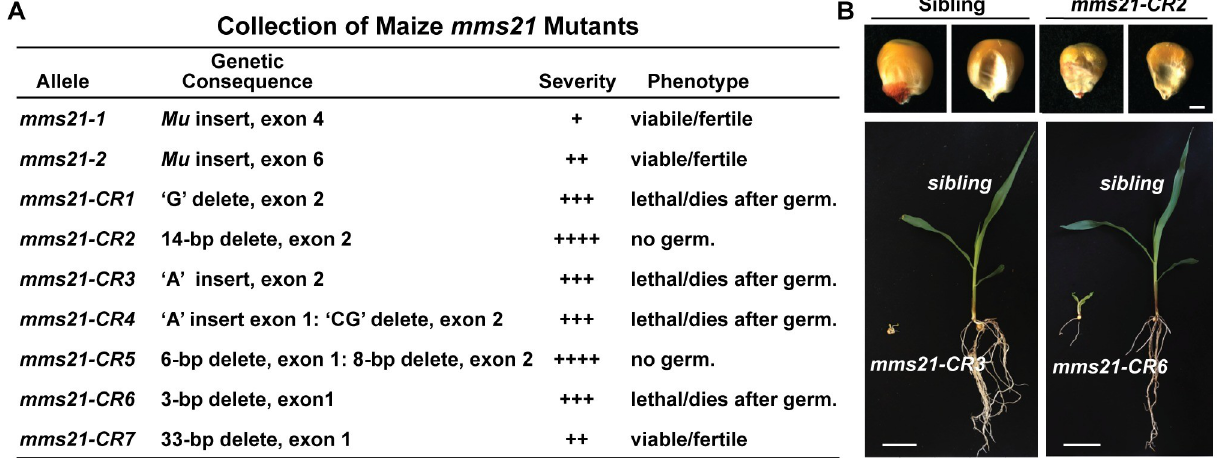
Fig 3. Strong mms21 Alleles Generated by CRISPR/Cas9 Lead to Seedling Lethality. (A) Comparisons of mms21 mutant alleles derived from Mutator and CRISPR/Cas9-mediated mutagenesis. The positions of the mutations and their phenotypic consequences are indicated. (B) Representative CRISPR/ Cas9-derived mms21-CR mutants showing the seed and seedling phenotypes as compared to their normal siblings. The seedlings were grown for 14 DAS.